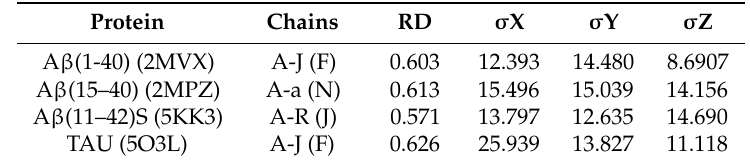
Table 1. Relative distance (RD) values for superfibrils. RD value calculated for the 3D Gaussian distribution covering the entire superfibril, the chains given in column 2. Chains in parentheses—middle chains in the fibril. The values of the parameters σ X, σ Y, and σ Z are given for expressing the aggregate orientation assuming compliance of the Z axis with the fibril axis. The chains given in brackets are oriented in the XY plane. Table 2. RD values for interfaces in superfibrils. Residues present in the interface are given. The